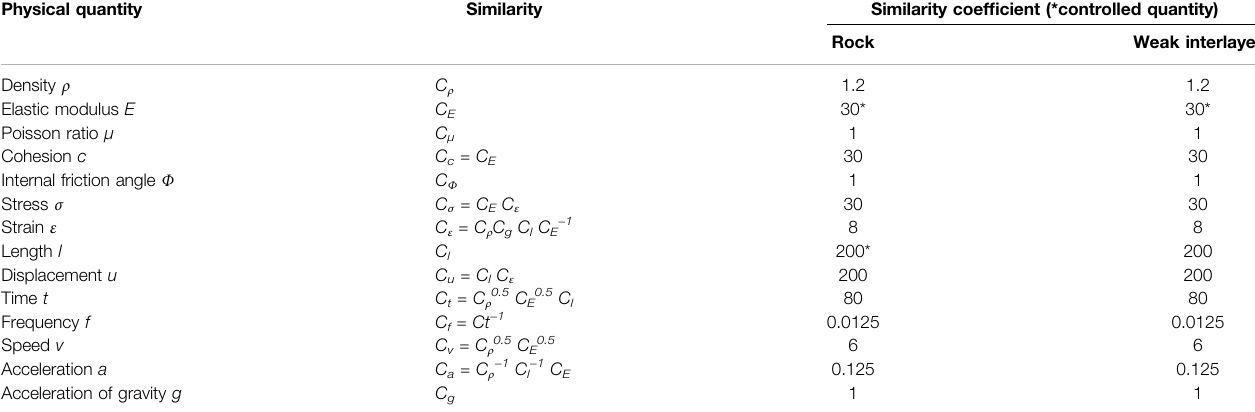
TABLE 1 | Similarity system for blasting physical model test.